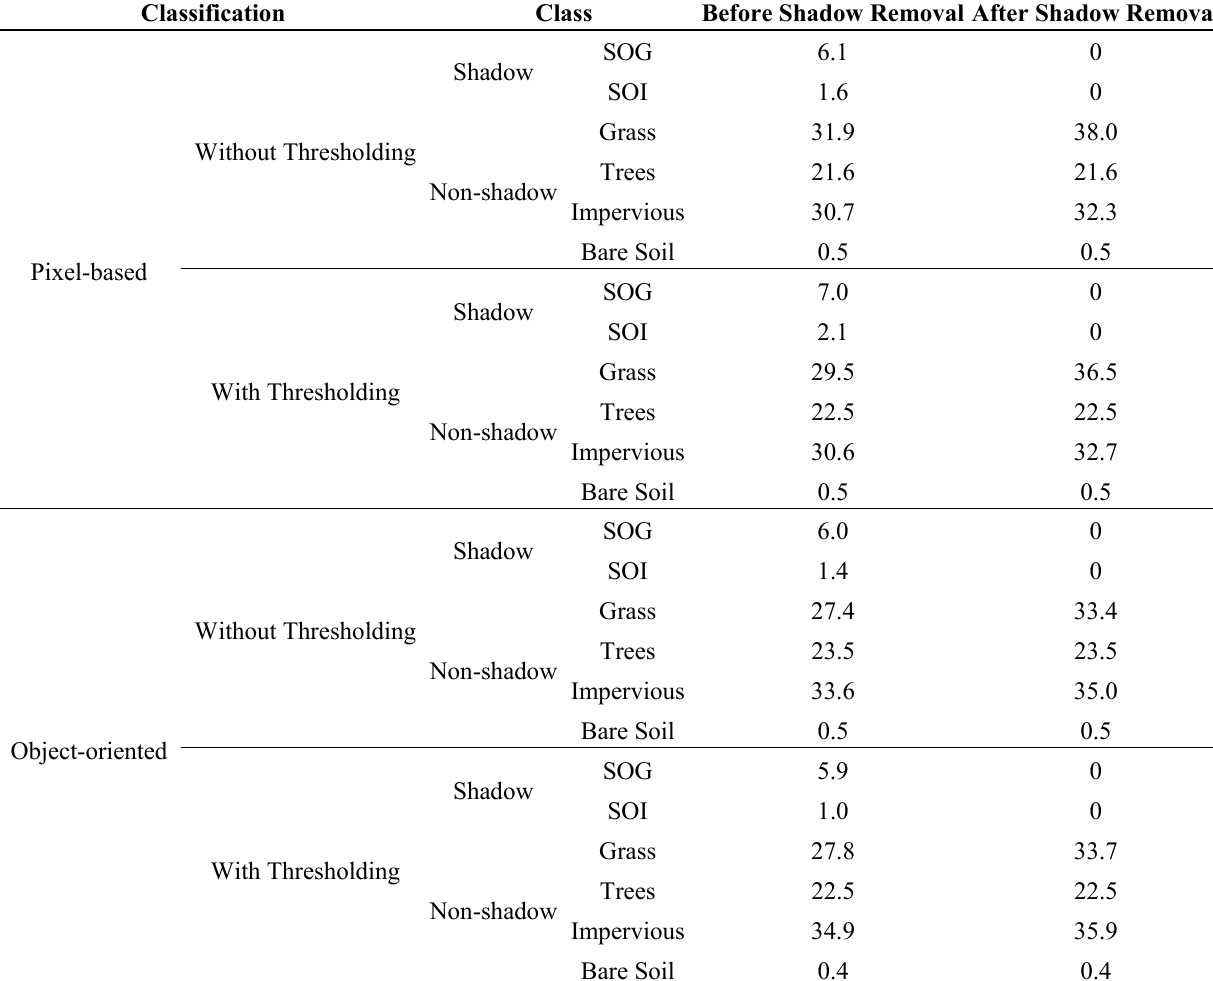
Table 2. Proportions (%) of shadow areas and land cover by type before and after the shadows were detected and removed with the pixel-based and object-oriented methods a